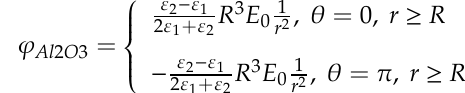
impregnated to iNF.